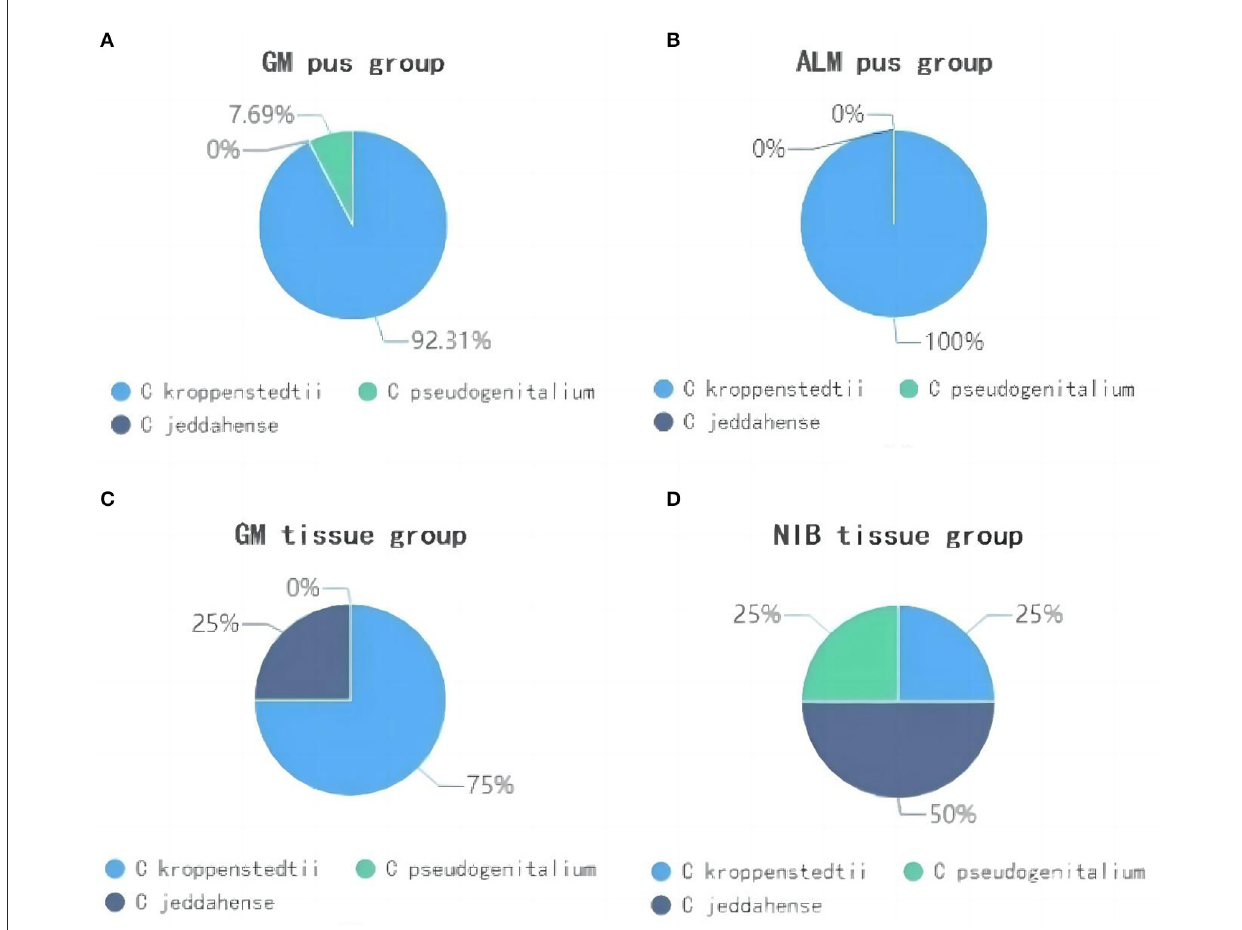
FIGURE6 The proportion of Corynebacterium species in four groups. (A) shows the GM pus group; (B) shows the ALM pus group; (C) shows the GM tissue group; (D) shows the NIB tissue